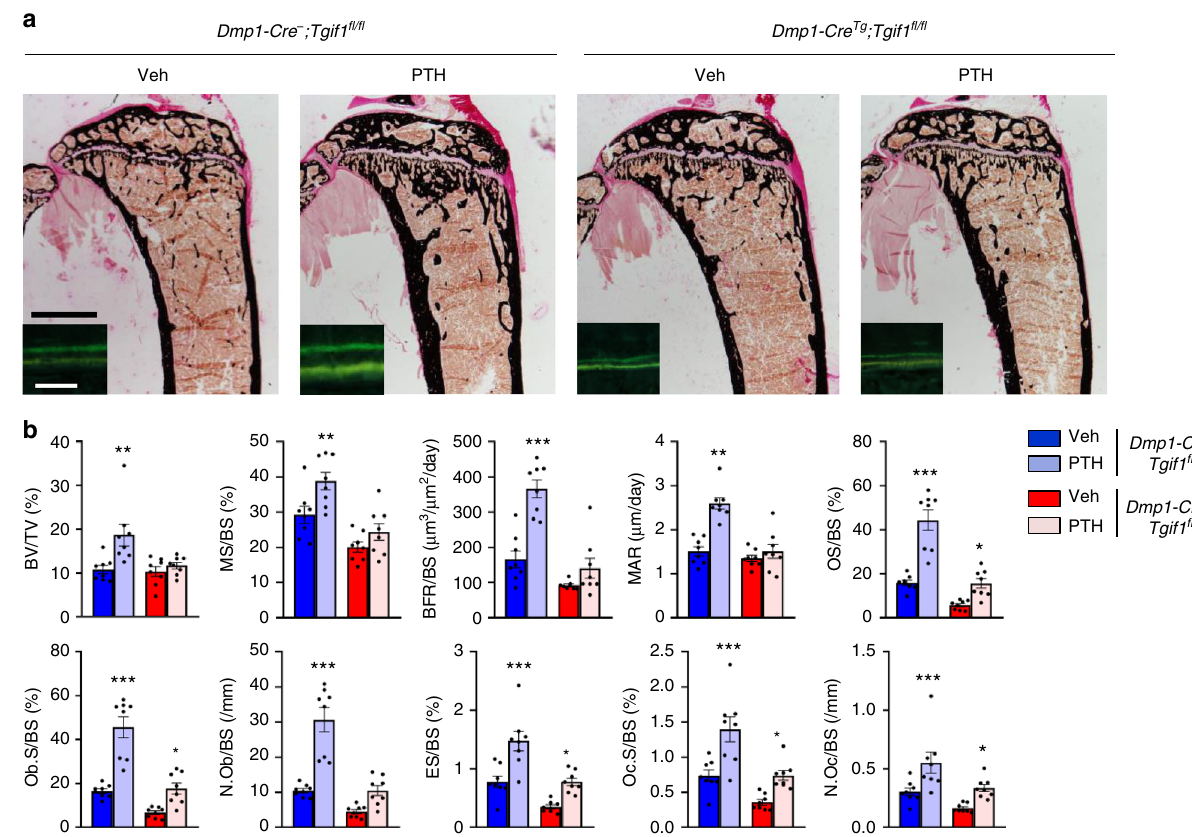
Fig. 6 Parathyroid hormone (PTH) elicits its bone anabolic effect in a TG-interacting factor 1 (Tgif1)-dependent manner. a Representative images of proximal tibiae of 12-week-old male mice with the genotypes Dmp1-Cre − ;Tgif1 fl / fl and Dmp1-Cre Tg ;Tgif1 fl / fl after von Kossa staining and fl uorescence double labeling to visualize bone formation (insets). Dmp1-Cre − ;Tgif1 fl / fl and Dmp1-Cre Tg ;Tgif1 fl / fl mice were treated with PTH or vehicle (Veh) for 4 weeks. Scale bars indicate 1 mm (black) and 50 μ m (white). b Histomorphometric analysis of the proximal tibiae of 12-week-old Dmp1-Cre − ;Tgif1 fl / fl and Dmp1-Cre Tg ; Tgif1 fl / fl male mice after PTH or Veh treatment for 4 weeks ( Dmp1-Cre − ;Tgif1 fl / fl + Veh: N = 8, Dmp1-Cre − ;Tgif1 fl / fl + PTH: N = 8, Dmp1-Cre Tg ;Tgif1 fl / fl + Veh: N = 8, Dmp1-Cre Tg ;Tgif1 fl / fl + PTH: N = 8). For abbreviations see the legend to Fig. 1. * p <0.05, ** p <0.01, *** p <0.001 vs. Veh of the same genotype. Error bars represent the s.e.m. Statistical analysis was performed using analysis of variance (ANOVA) followed by Newman – Keuls post-hoc 4 weeks into 8-week-old Dmp1-Cre Tg ;Tgif1 fl / fl mice and control